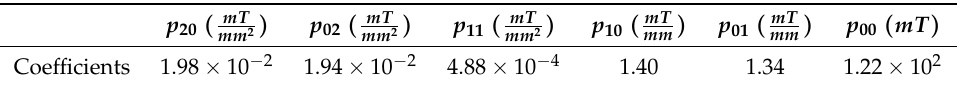
Table 2. Coefficients in the empirical formula for the magnetic flux density distribution on the cross-section of the investigated transformer.